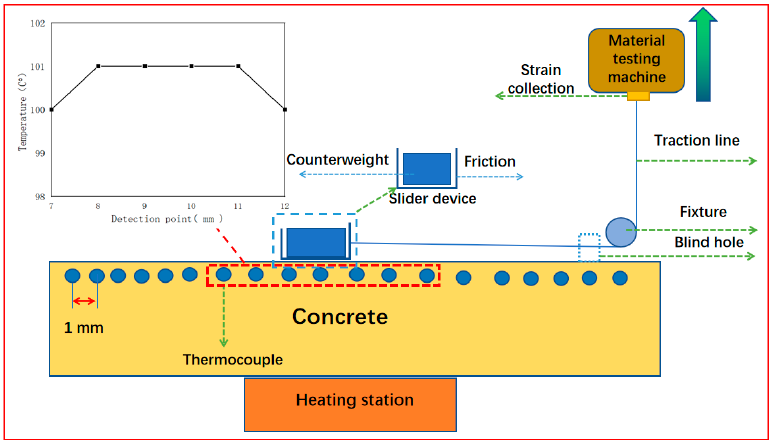
Figure 1. Temperature change concrete material friction performance test device.